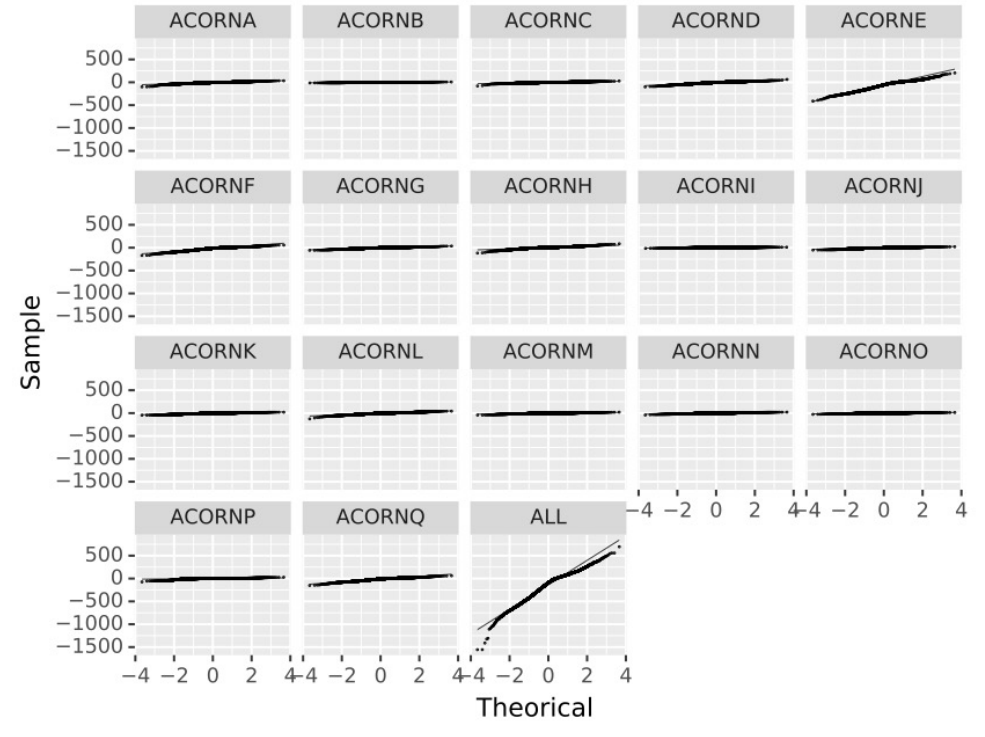
Figure 3. Residuals q-q Plot for each ACORN group and all the customers